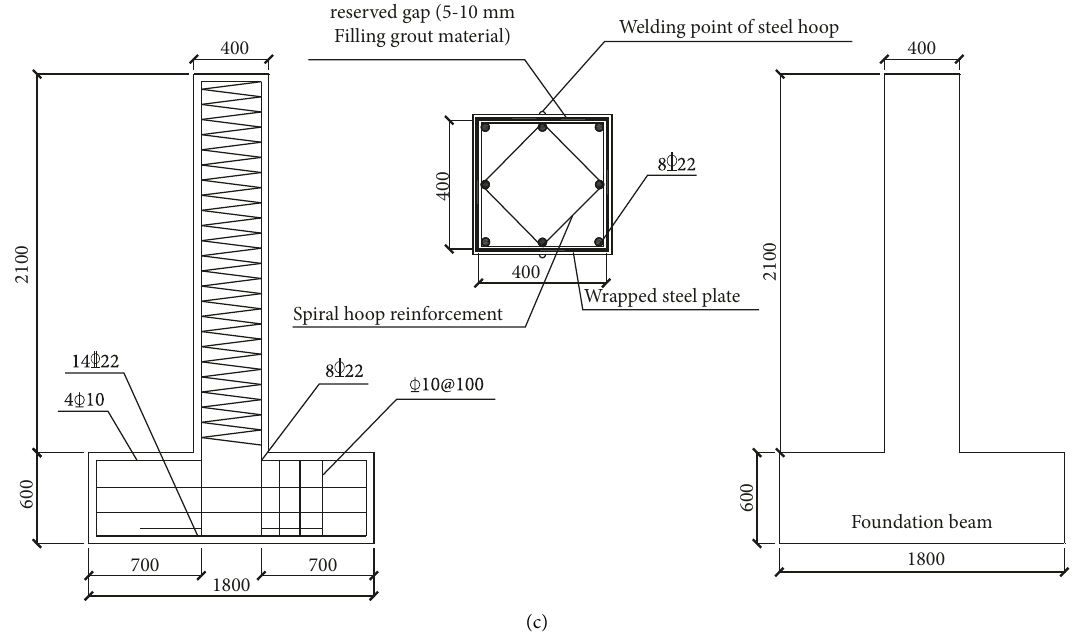
Figure 1: Structural details of specimens. (a) W01 and W02. (b) W03. (c)